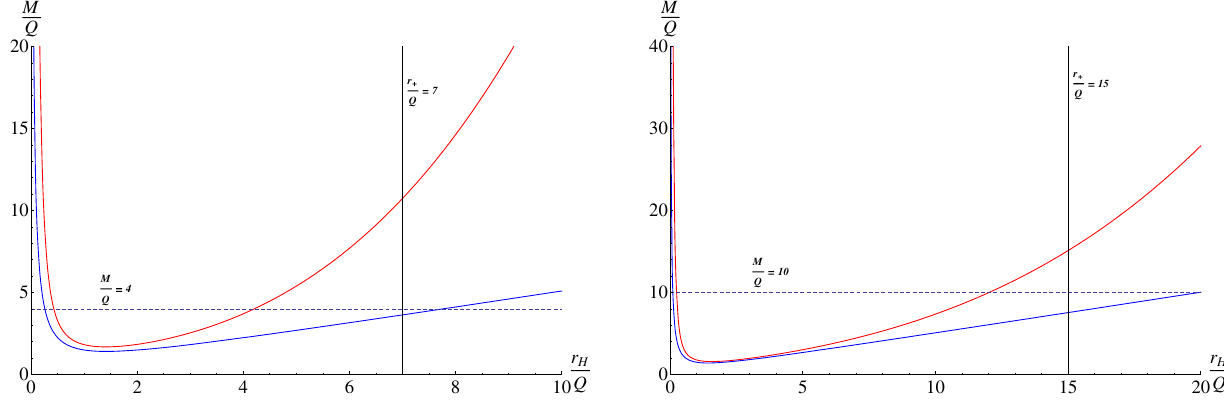
Fig. 4 The reduced mass M / Q of the non-extremal black hole is plotted in terms of the reduced horizon radius r H / Q , at l / Q = 5 (left) and l / Q = 15 (right). The red and blue curves refer to the non-linear charged black hole of this work and the RN-AdS black hole,